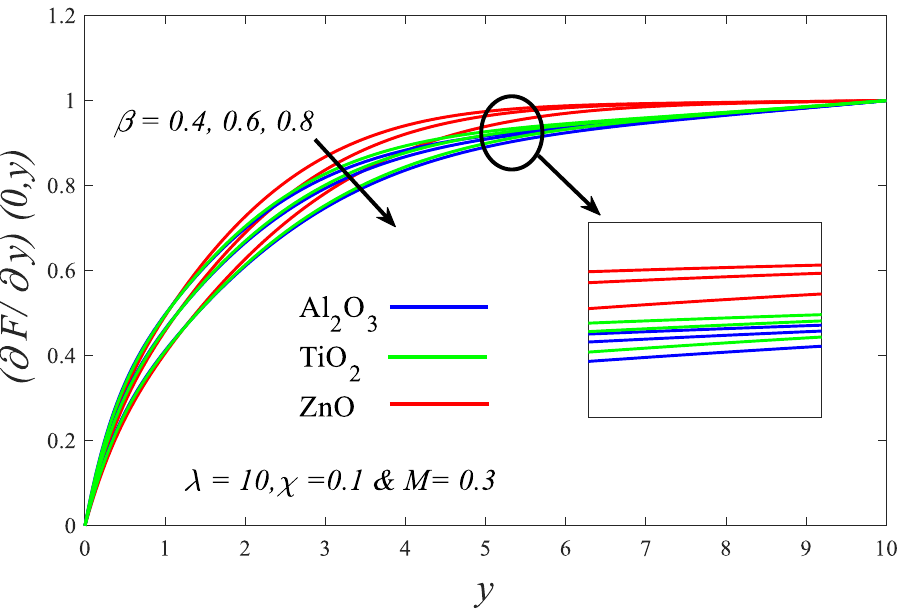
/   F y  Figure 15. Impression of β on ∂ F / ∂ y . The inset is a partial enlargement of the curves. Figure 15. Impression of on . The inset is a partial enlargement of the curves. Figures 16 and 17 show that with the increasing values of the magnetic parameter, the temperature rises but the velocity reduces. Of course, this will happen because crossing a magnetic field through a moving fluid generates a force called the Lorentz force. This force generates a kind of friction in the flow, which in turn generates more heat energy, which eventually increases the temperature. Additionally, increasing the intensity of the magnetic field aims to strengthen the force of friction, which curbs the flow of the fluid and slows its velocity. It is also noticed that zinc oxide–kerosene oil gains the highest velocity and temperature regardless of the values of the parameters affecting it.